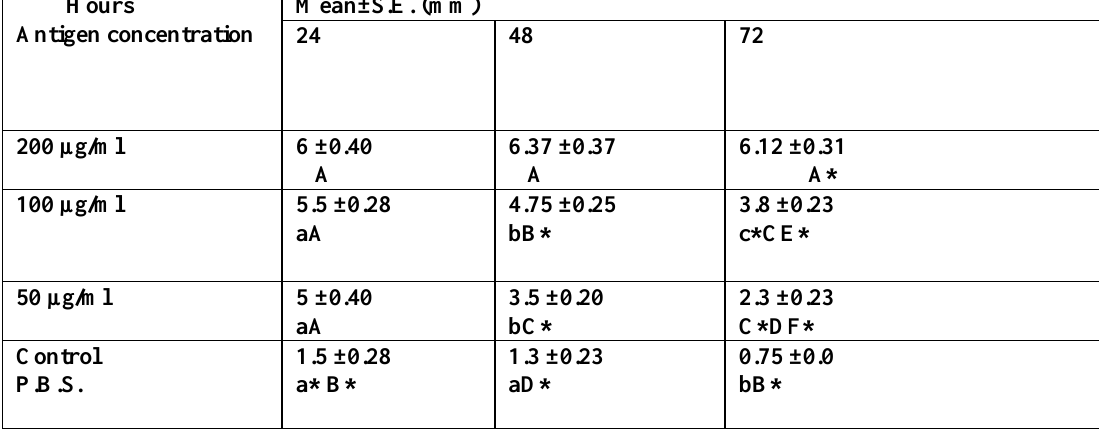
Table 5: Indurations of delayed type hypersensitivity in the immunized rabbits with Proteus vulganis fimbriae antigen at concentration 200